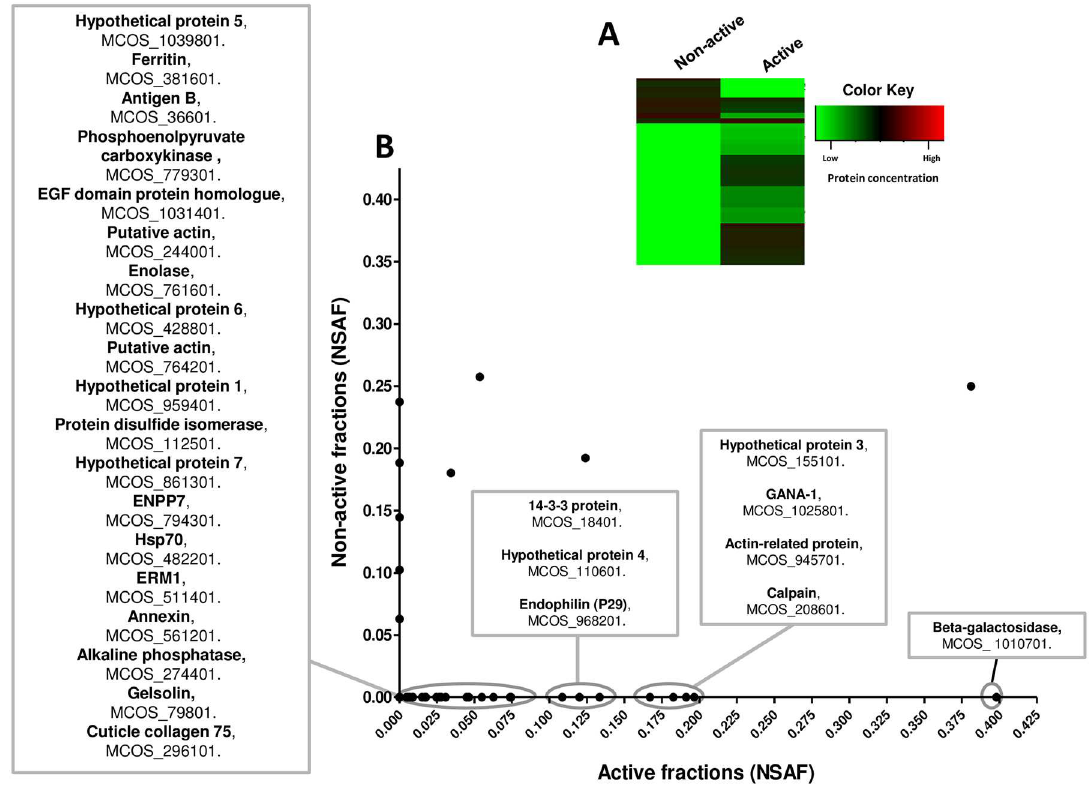
Fig 10. Mass spectrometric-based comparative proteomic analysis of active vs. non-active fractions of McES. (A) Heat map showingthe mean relative abundanceof the indicatedproteins identifiedin all McES fractions investigated. (B) Bivariant plot of NSAF values of proteins from active and non-active McES fractions. McES fractions after gel filtration chromatography were separated into active vs. non active dependingon their ability to impair LPS-drivenBMDC activation. 3–4 fractions from the most active and non-activefractions were lyophilized and analysedby LC-MS/MS. Proteins exclusivelypresent in active fractions are displayedin grey boxes in a descendingorder of NSAF values. For the active or non-activegroup of fractions, the computedNSAF value of a given protein is the mean of the individualNSAF values of this protein in the 3–4 different fractions analyzed.